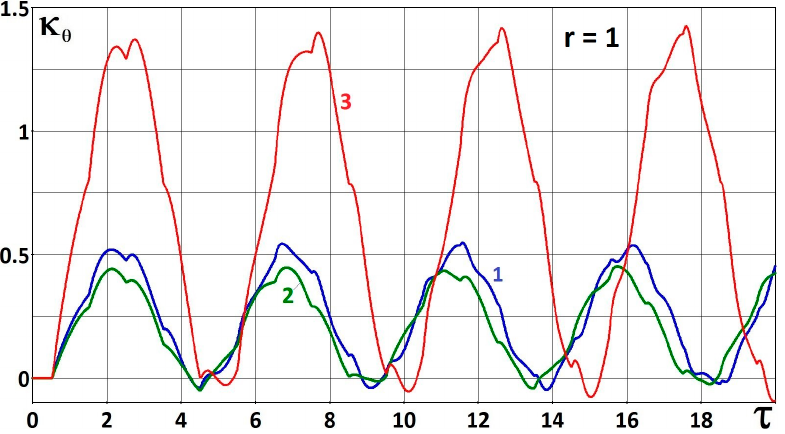
Figure 12. Time history of the relative circumferential stress at r = 1. Elastic materials. FGM cylinder—curve 1; two-layer cylinder—curve 2; homogeneous cylinder—curve 3.